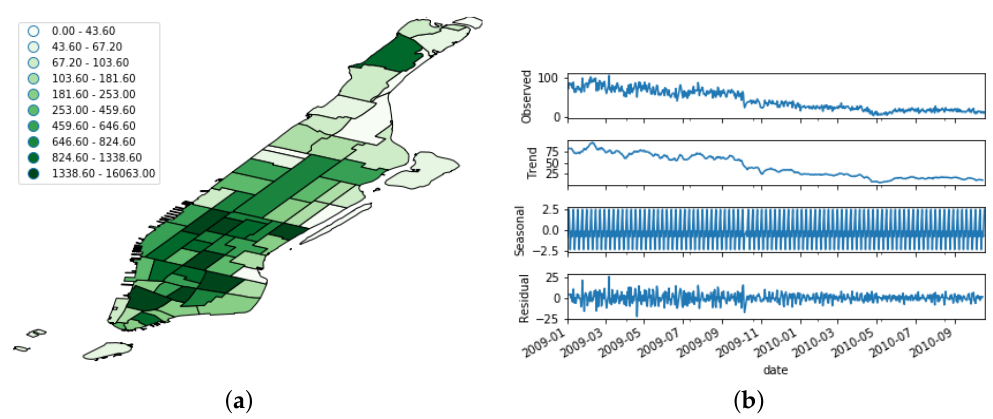
Figure 7. Distribution of the Brightkite dataset. ( a ) Spatial distribution; ( b ) Temporal evolution. The uppermost figure shows the raw time series, whereas the other bottom ones depict its decomposition in trend, seasonal, and noise features. Table 1. OSN raw dataset details during the target time period of January 2009 to October 2010.